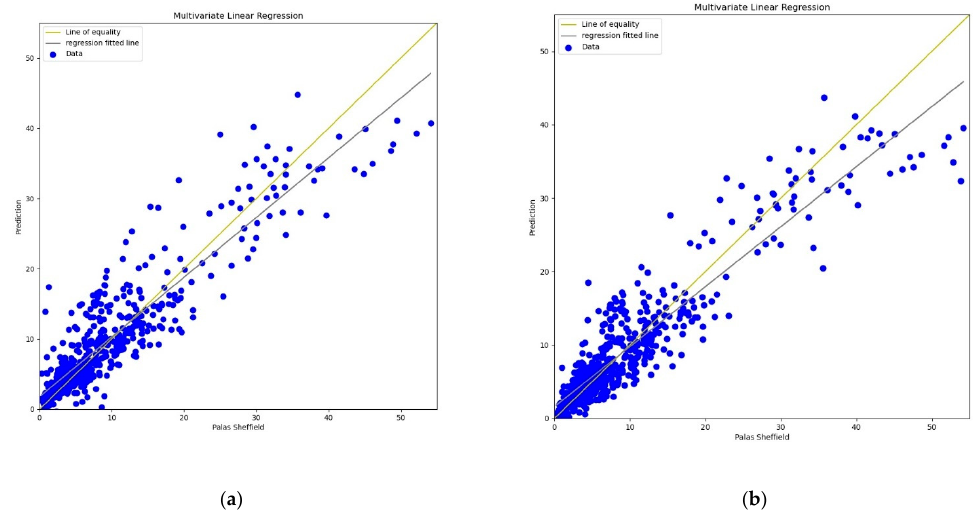
Figure 5. ( a ) MLR calibration scatter plot for PM 2.5 with the line of equality, regression fitted line, and the calibrated data using AH ; ( b ) MLR calibration scatter plot for PM 2.5 with the line of equality, regression fitted line, and the calibrated data using RH .